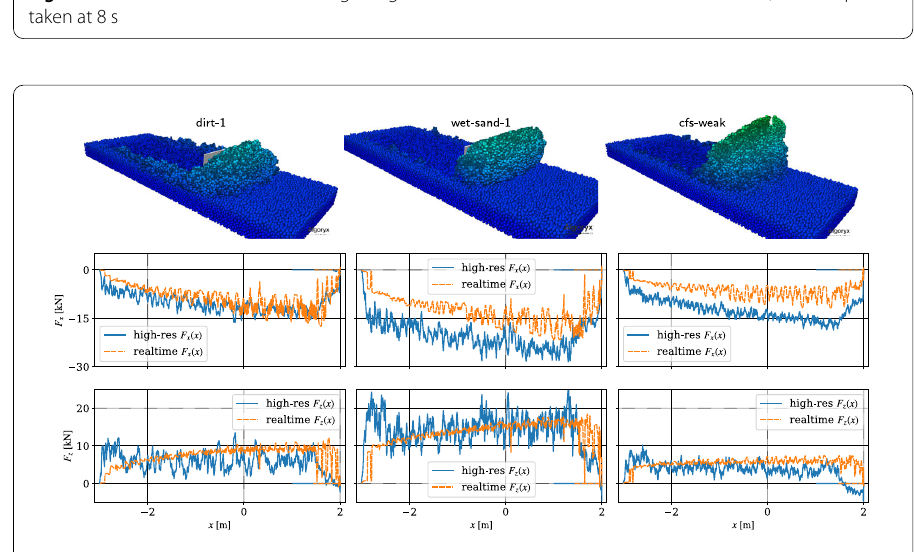
Fig. 10 Force resistance from bulldozing using three cohesive soils and the microscale model, with snapshot taken at 8